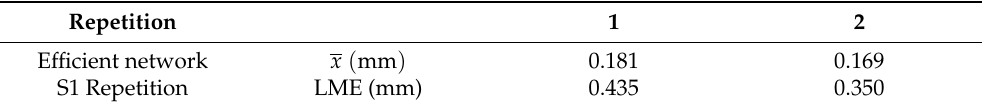
Table 5. Results of the repetition of Scenario 1 with high-level extrinsic parameters and an efficient network.